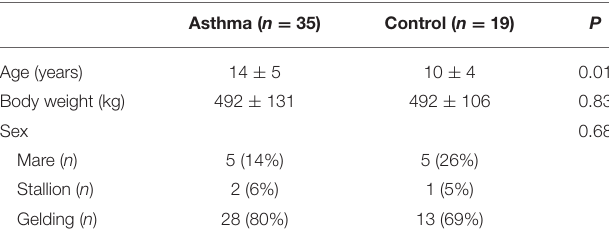
TABLE 1 | General characteristics of enrolled asthmatic and control horses (mean ±